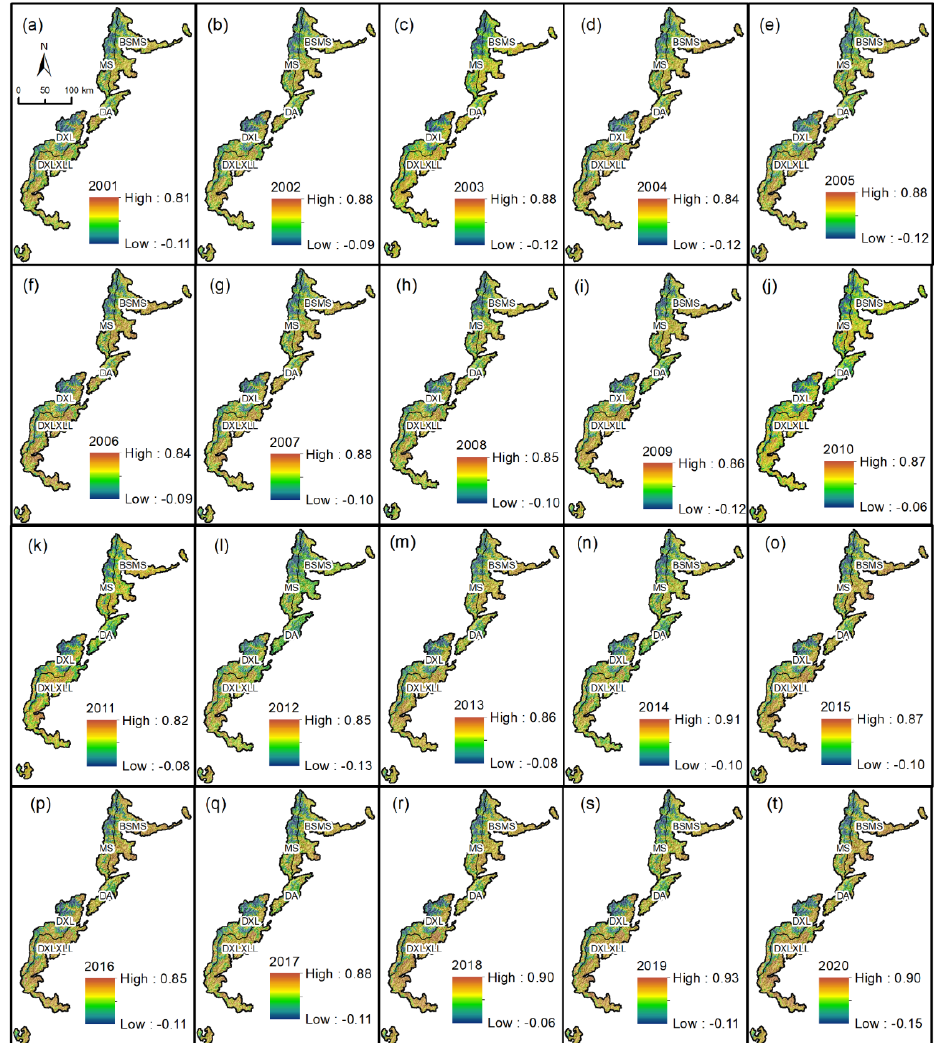
Figure A1. NDVI images from 2001 to 2020 in the study area.